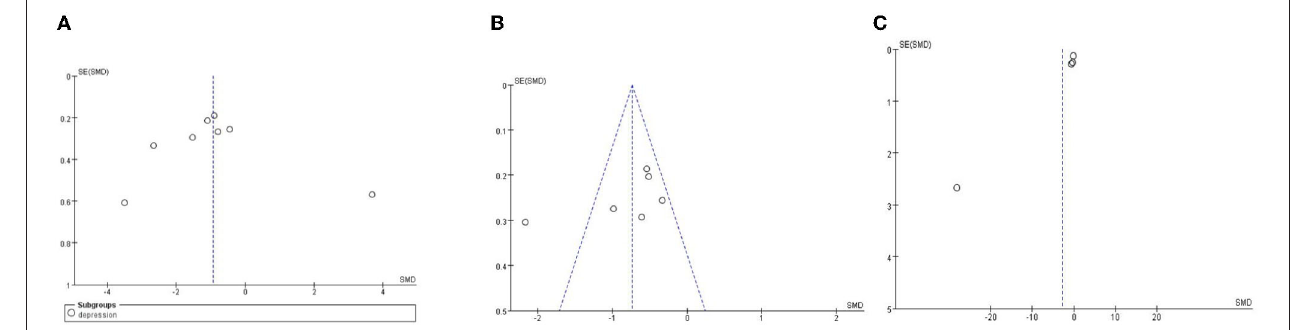
FIGURE 6 | Publication bias analysis of depression (A) , anxiety (B) , sleep disorder (C)